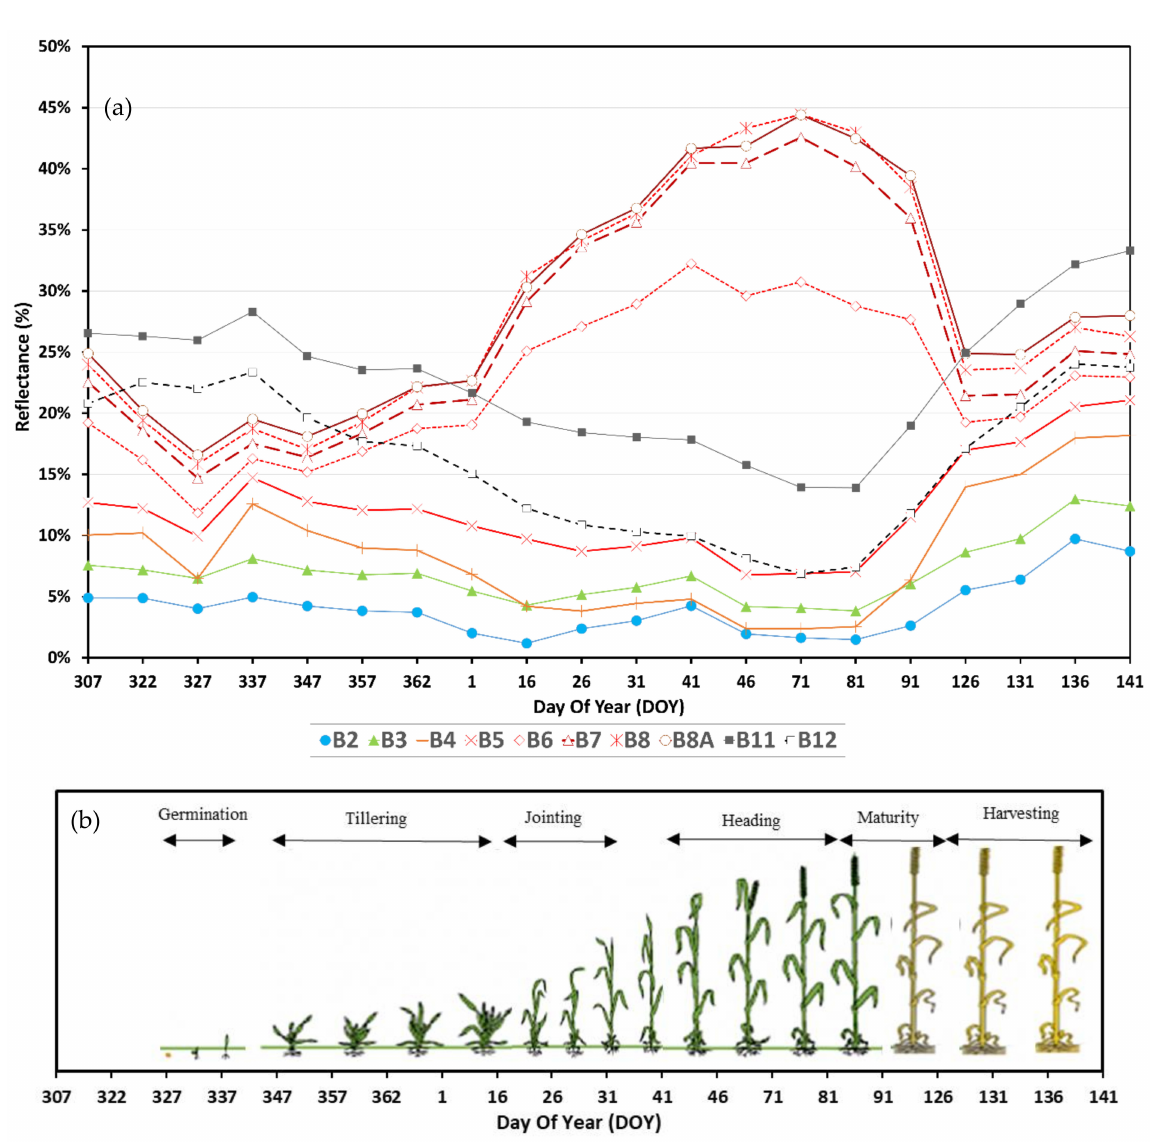
Figure 5. Mean temporal profiles of Sentinel-2 reflectance ( a ) and main phenological stages for wheat ( b